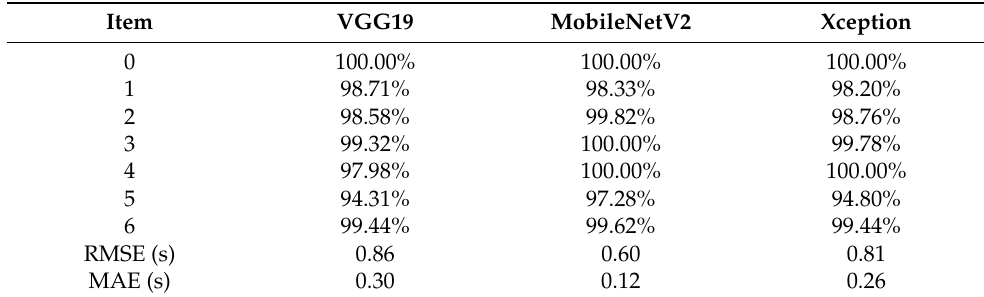
Table 2. Recall rates of the models for the drinking test